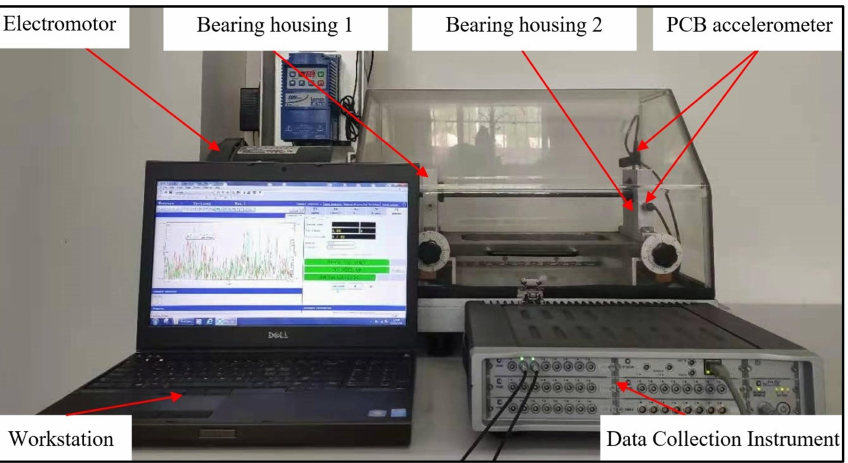
Figure 9. Test system based on the Simcenter Testlab and MFS-LT. Table 3. Detailed parameters of the damaged bearings.